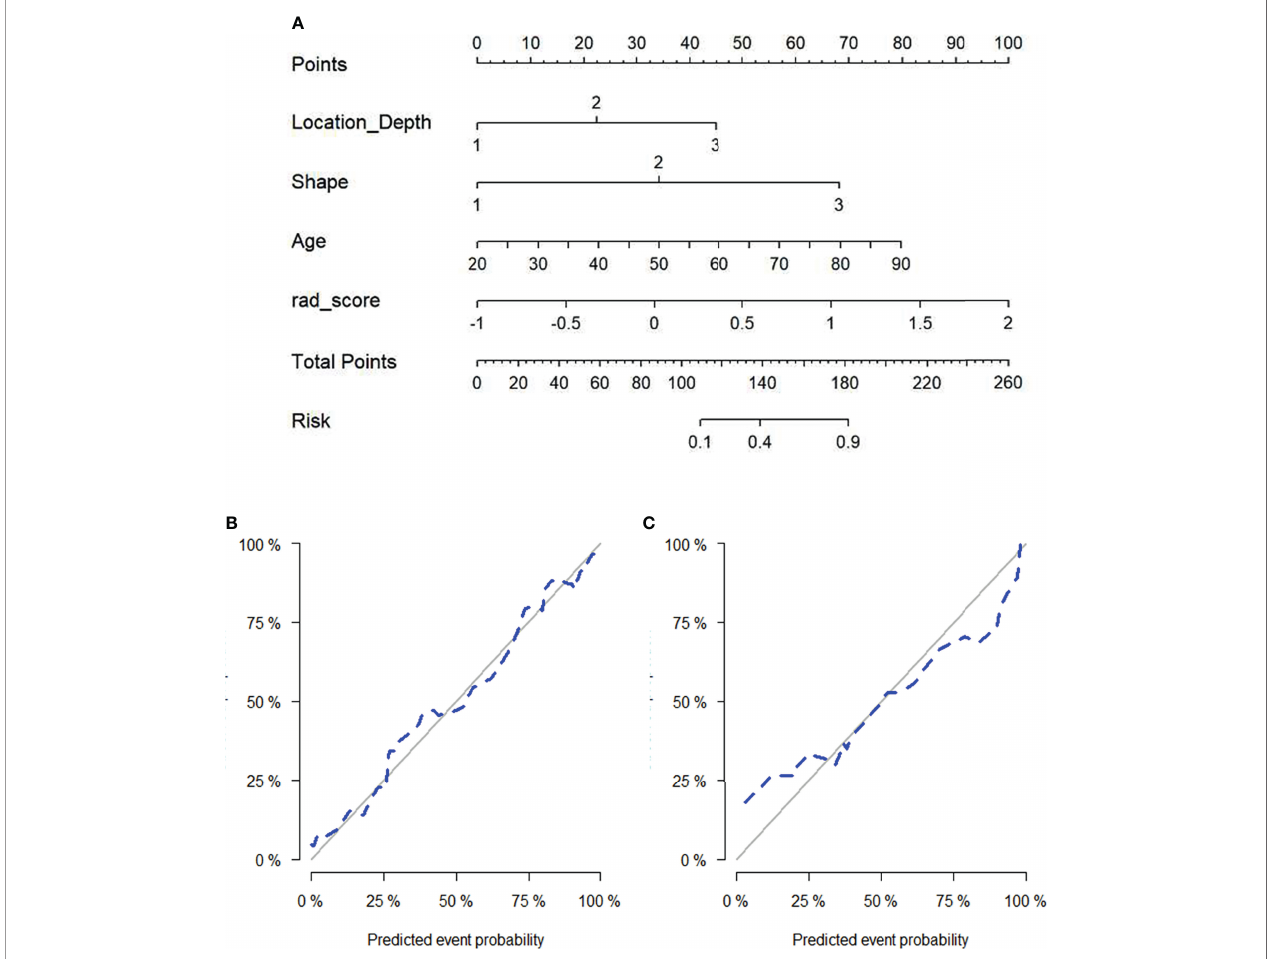
FIGURE 5 | Radiomics nomogram for predicting malignantstatus ofround-liketumors (A) . Calibrationcurvesoftheradiomicsnomograminthetrainingset (B) andtestset (C)